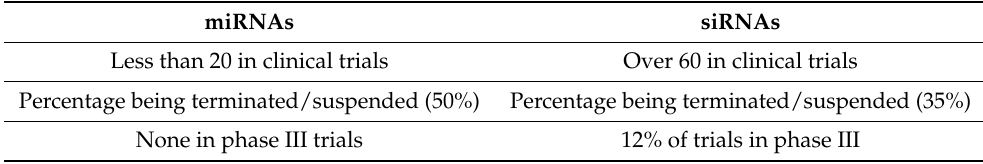
Table 3. Current status in the development of miRNAs